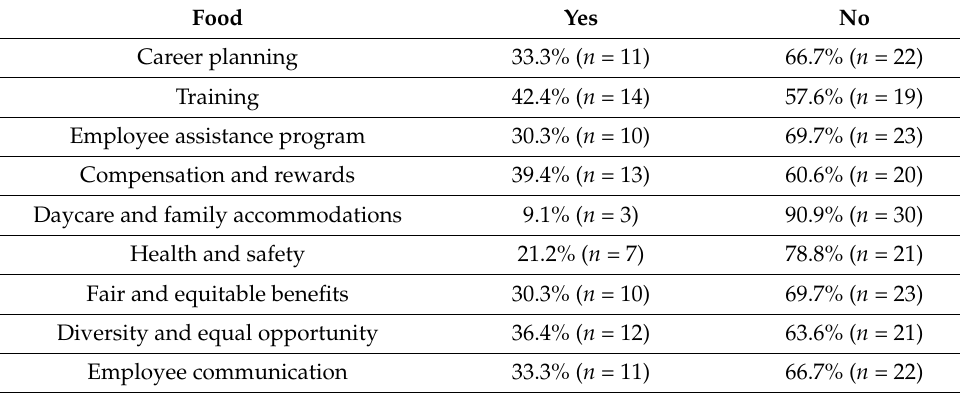
Table 10. Aspects of CSR activities: